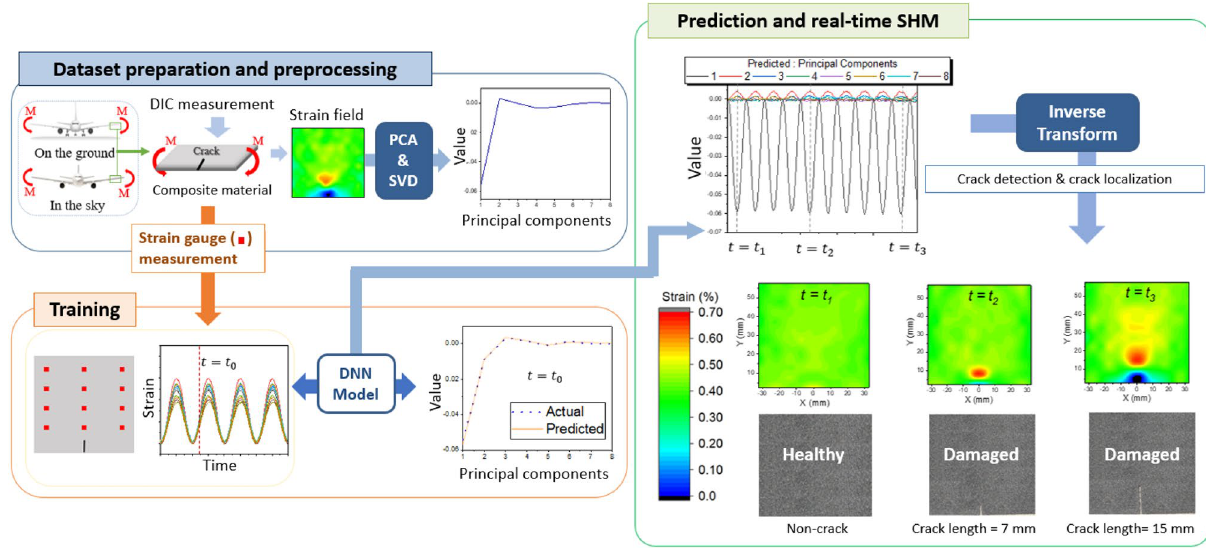
Figure 1. Framework of the proposed method for real-time structural health monitoring using strain gauge